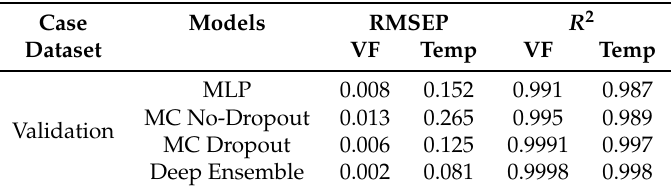
Table 5. Performance of the models on validation dataset of the computational domain, VF: Void Fraction, Temp: